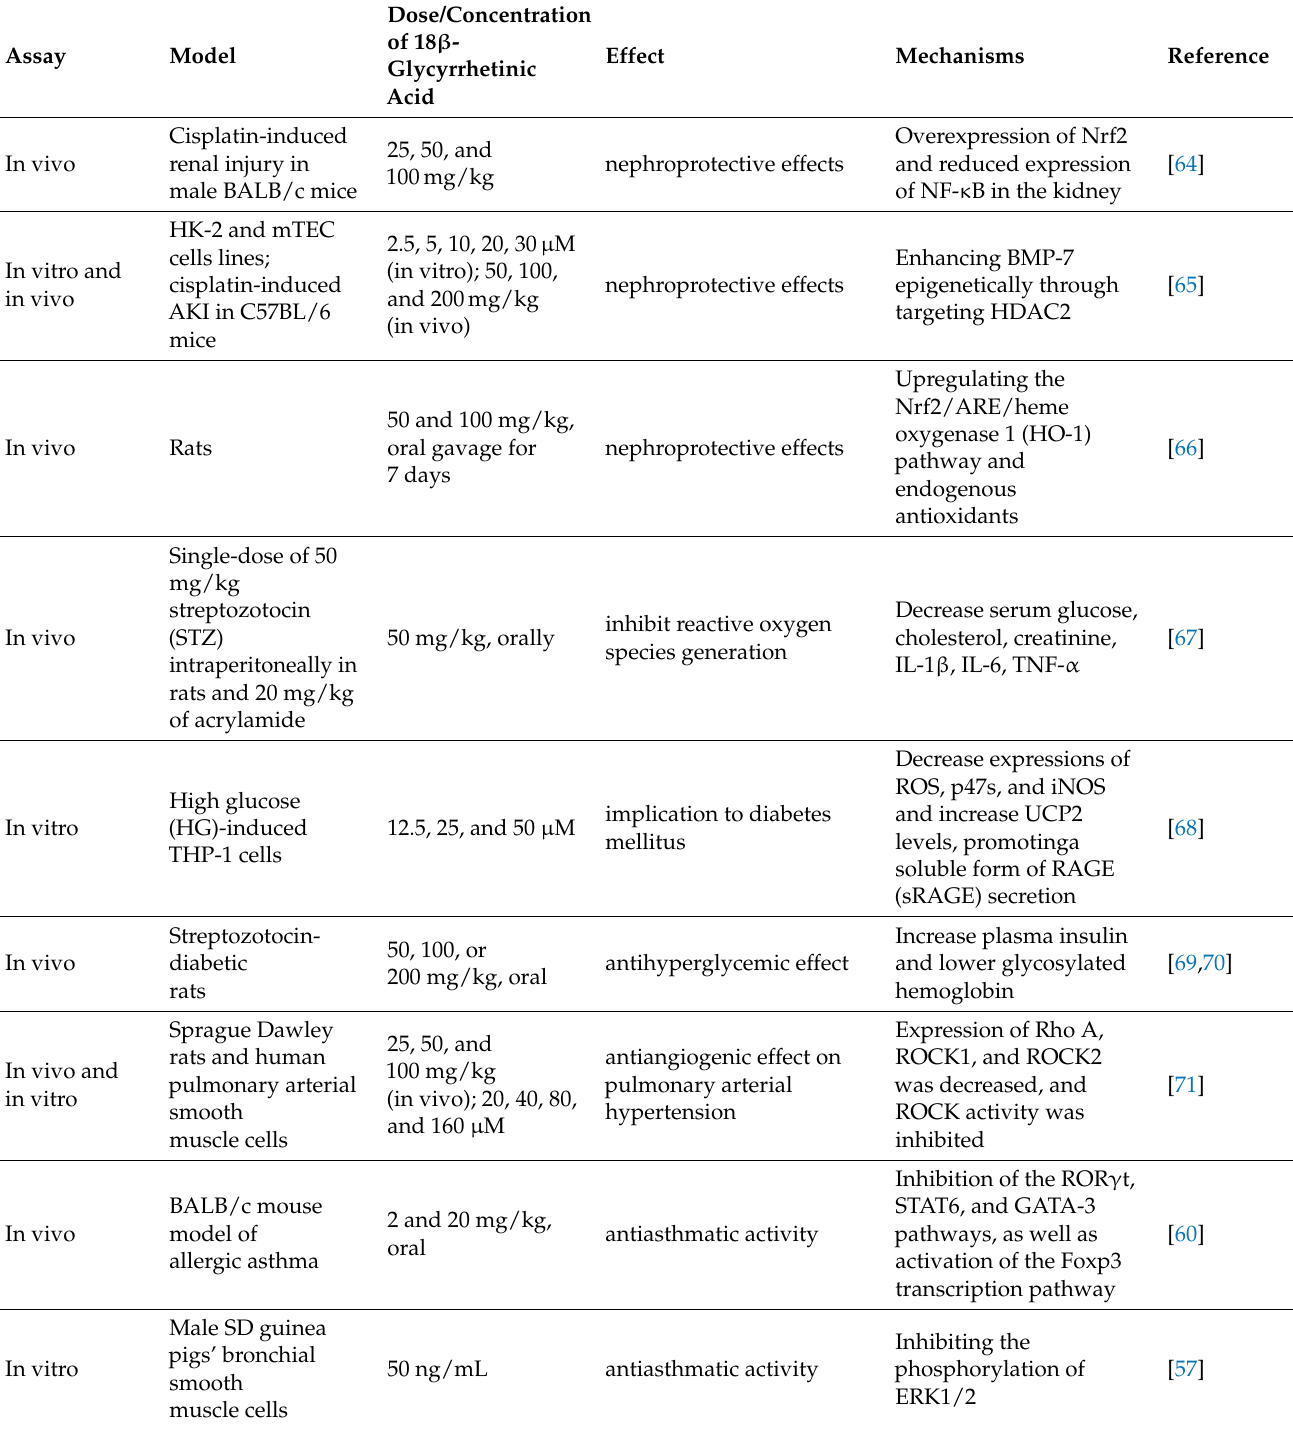
Table 2. Nephroprotective, antidiabetic, antiasthmatic, and management of pulmonary arterial hypertension and mechanisms of 18 β -glycyrrhetinic acid in both in vitro and in